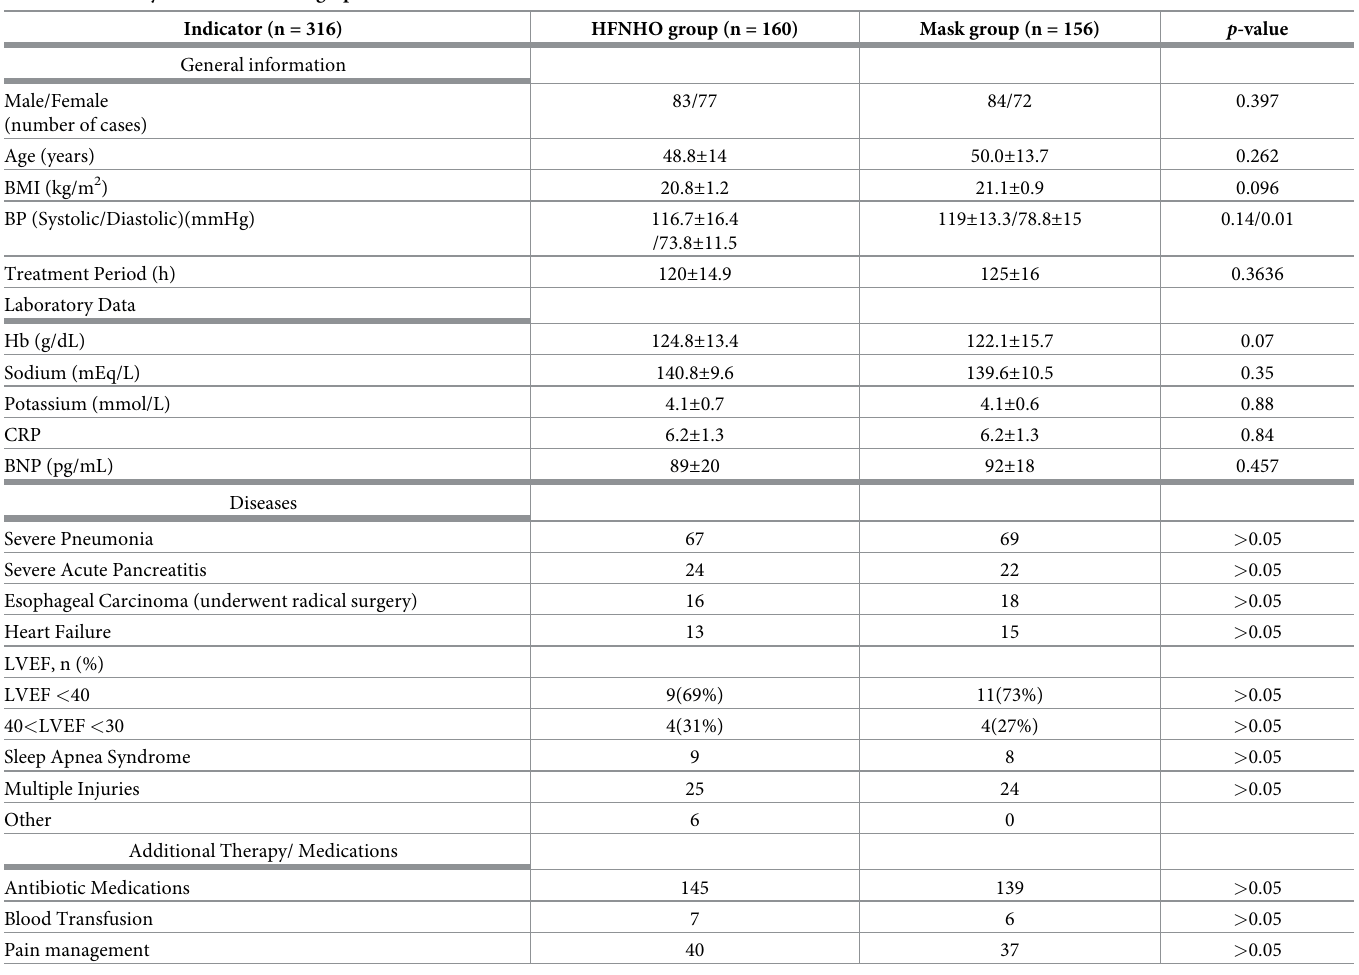
Table 1. Summary statistics for